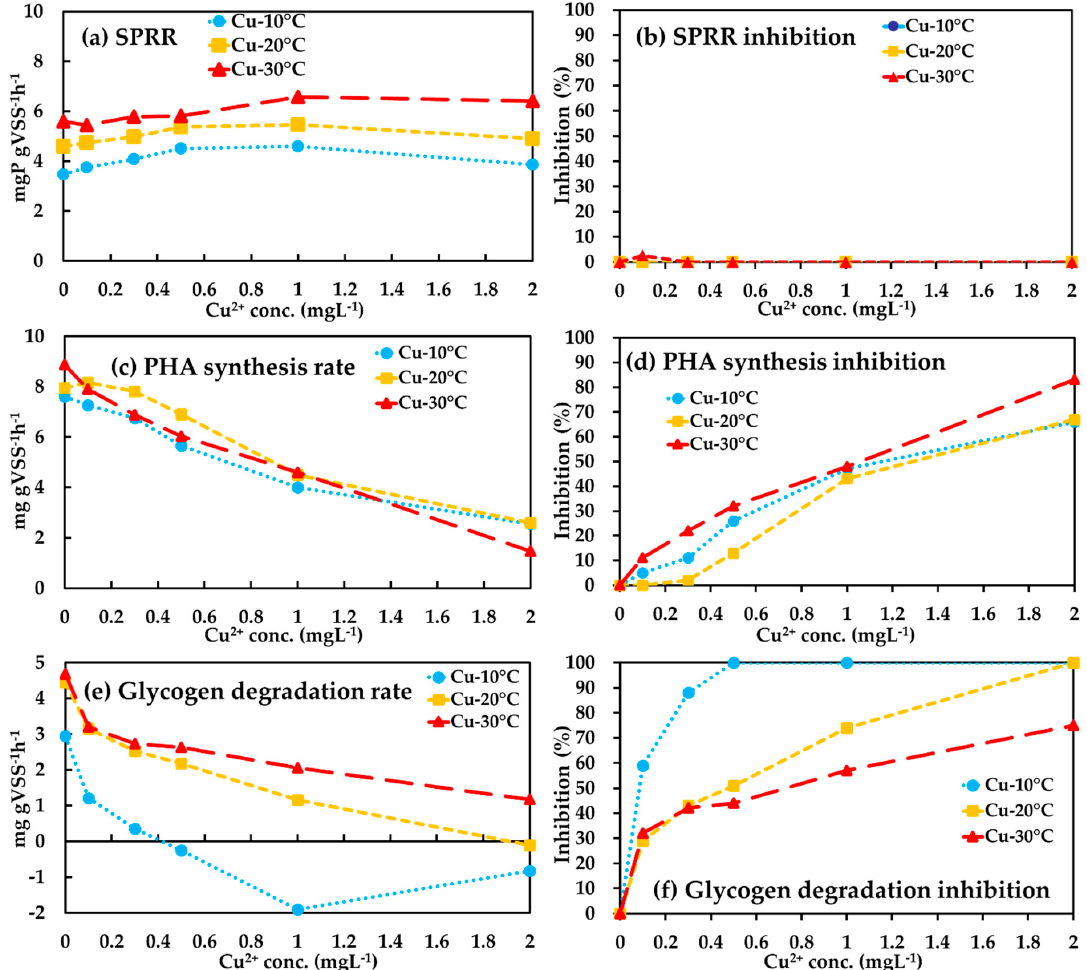
Figure 2. Toxic effects of Cu(II) on anaerobic specific phosphate release rate (SPRR), PHAs synthesis, and glycogen degradation under different temperature conditions. ( a ) SPRR; ( b ) SPRR inhibition; ( c ) PHA synthesis rate; ( d ) PHA synthesis inhibition; ( e ) Glycogen degradation rate; ( f ) Glycogen degradation inhibition.